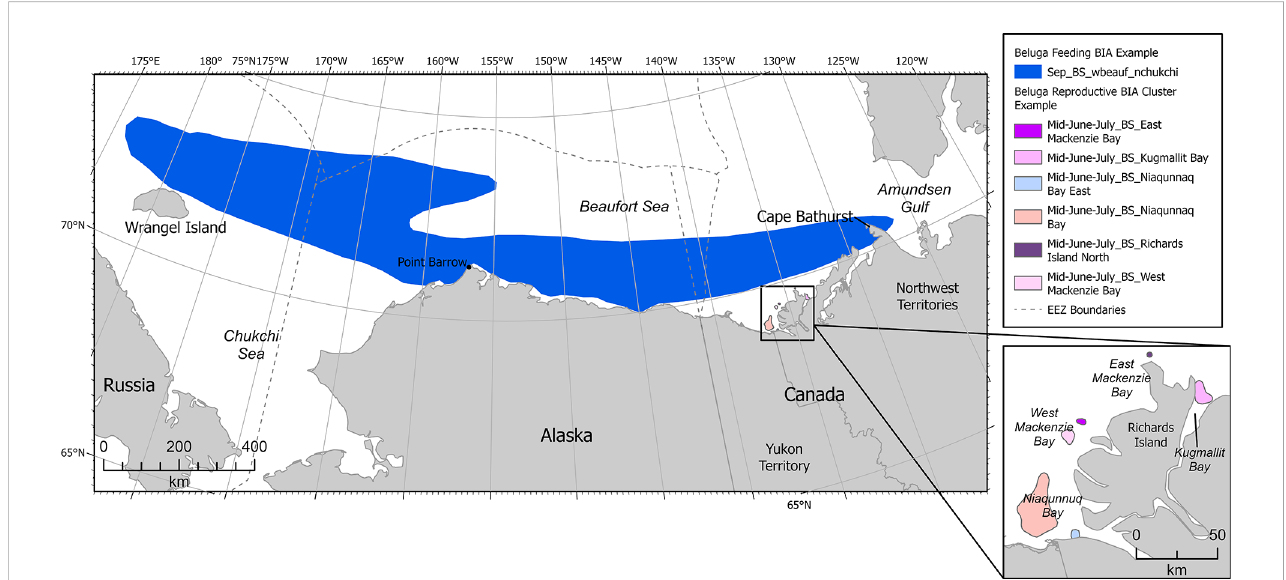
FIGURE 5 Example Arctic region BIAs showing beluga international (Beluga – Beaufort Sea Stock - Feeding) and cluster (Beluga – Beaufort Sea Stock - Reproductive BIA, inset map)